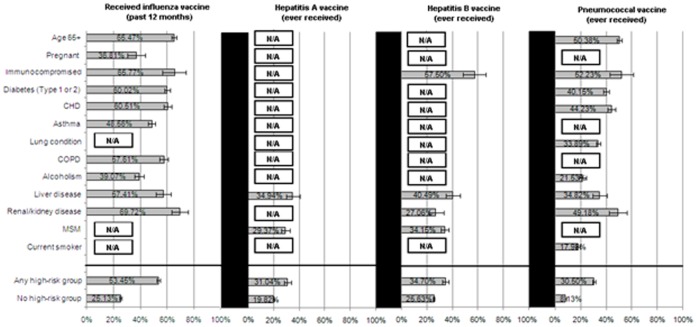
Percentage of high-risk groups who have been vaccinated.N/A: risk category is not applicable to this particular vaccine according to the ACIP; immunocompromised: (HIV/AIDS); CHD: Congestive heart failure, heart attack, angina, arrhythmia; lung conditions: COPD/emphysema/bronchitis, asthma; liver disease: Hepatitis B, Hepatitis C, chronic liver disease, cirrhosis; renal/kidney disease: chronic kidney disease, moderate-severe renal disease; MSM: men who have sex with men; Any high risk group: membership in any of the high-risk categories above.